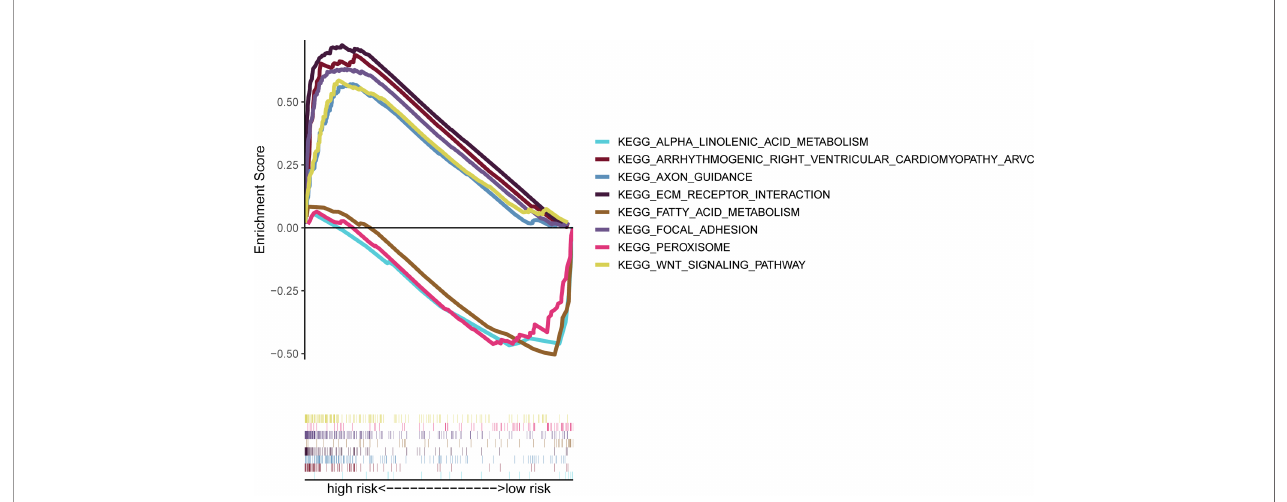
FIGURE 7 | Gene set enrichment analysis of biological functions and pathways.